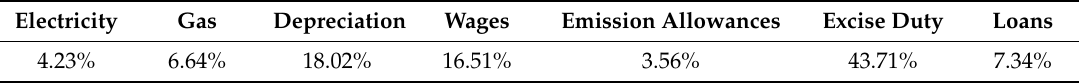
Table 5. Cost structure and contributions.